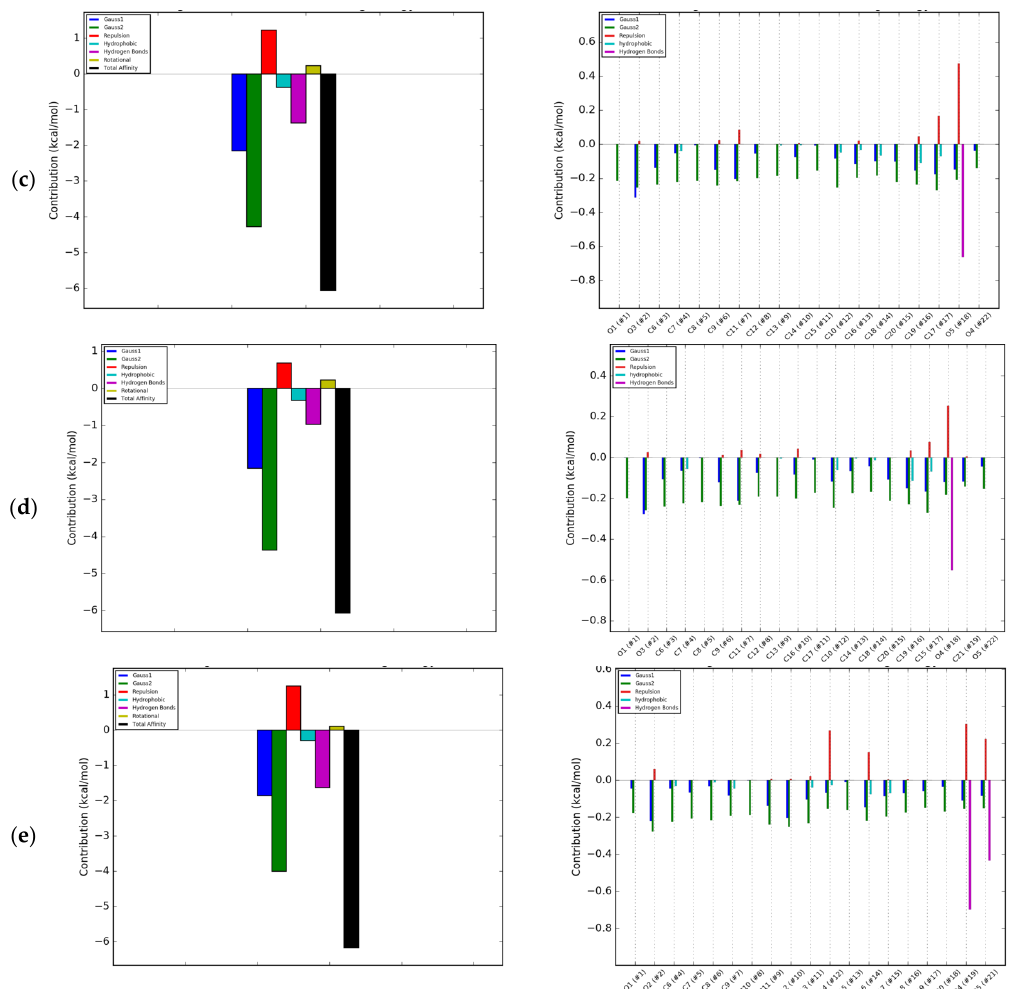
Figure 4. Energetic contributions to binding energy of RANKL and: ( a ) Daidzein; ( b ) Formononetin; ( c ) Genistein; ( d ) Biochanin A; ( e ) Coumestrol; blue bar—Gauss 1 interactions; green—Gauss 2 interactions; red—Repulsion; light blue—Hydrophobic interaction; magenta—Hydrogen bonds; olive—Rotational; back—Total affinity.